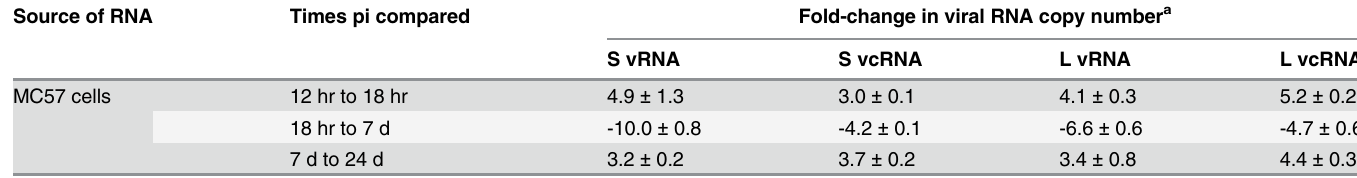
Table 6. Fold-change in LCMV replicative RNA species over the course of